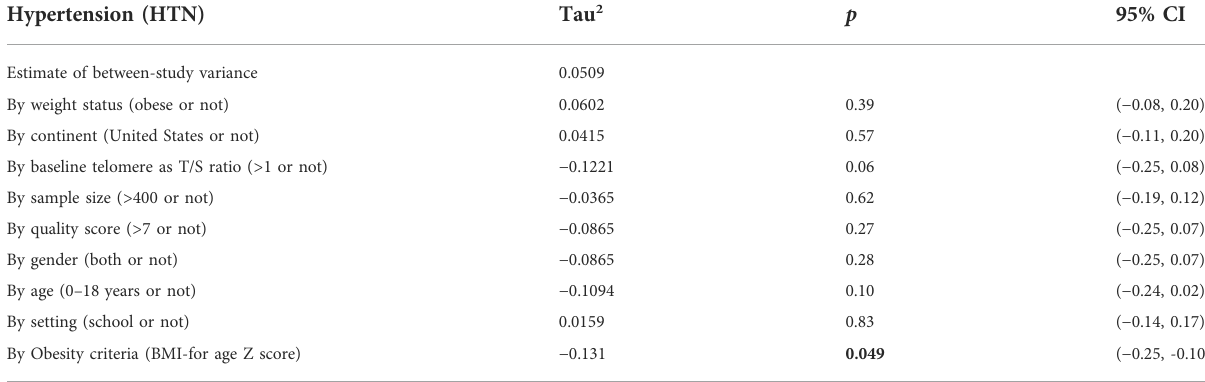
TABLE 5 Meta regression approach in the two-class meta-analysis.